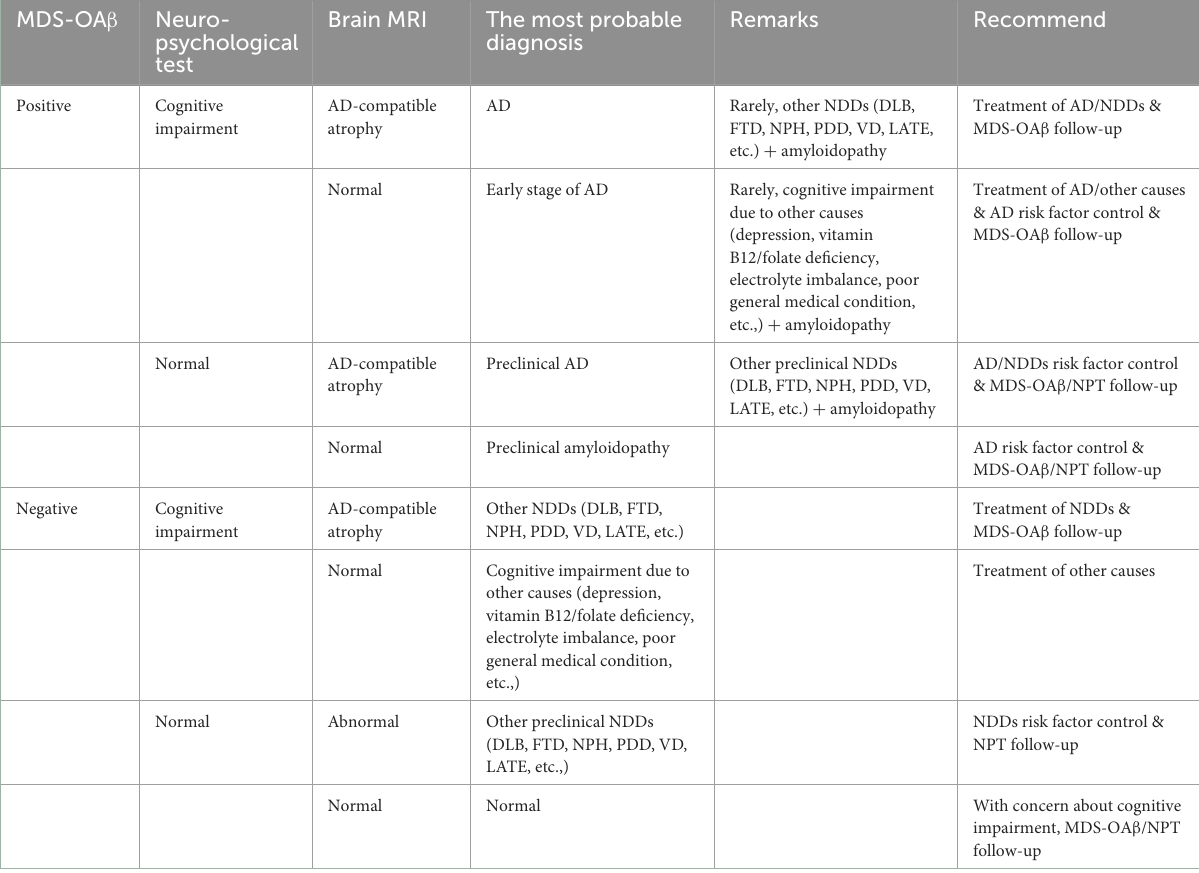
TABLE 1 Interpretations of MDS-OA β , neuropsychological test, and brain MRI. MDS-OA